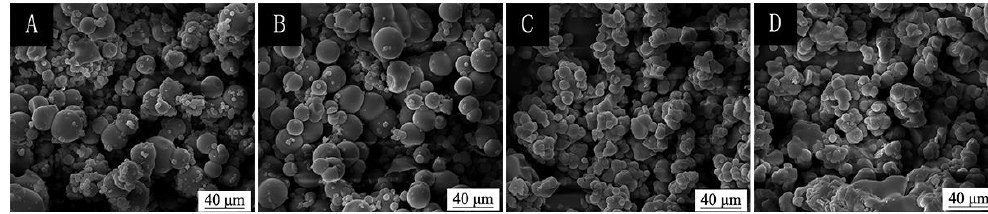
Figure 4. SEM picture of single factor test: ( A ) 400 rpm; ( B ) 600 rpm; ( C ) 800 rpm; ( D ) 1000 rpm.